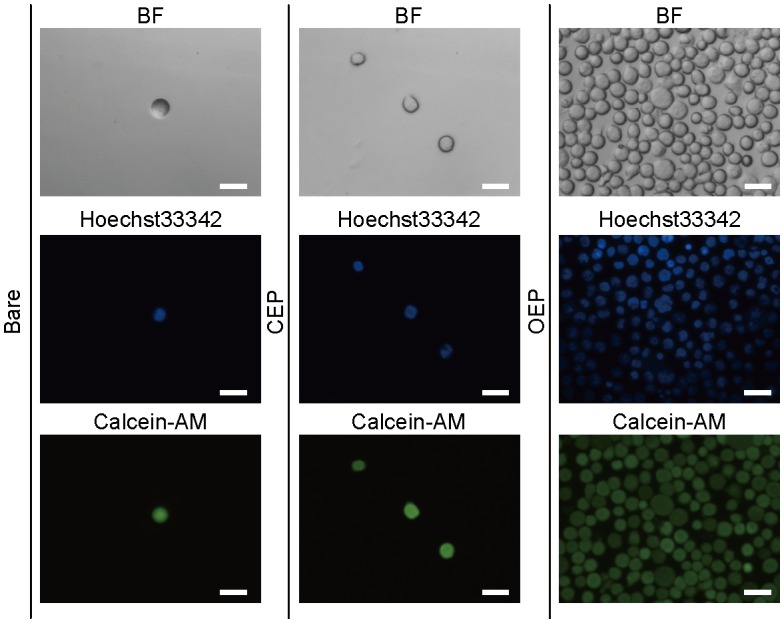
Images of Jurkat T cells on the bare Ta2O5, CEP SAM, and OEP SAM surfaces. BF: bright field. Cell nucleus and cytoplasm were stained by Hoechst 33342 and calcein, respectively. Scale bars: 20 μm.